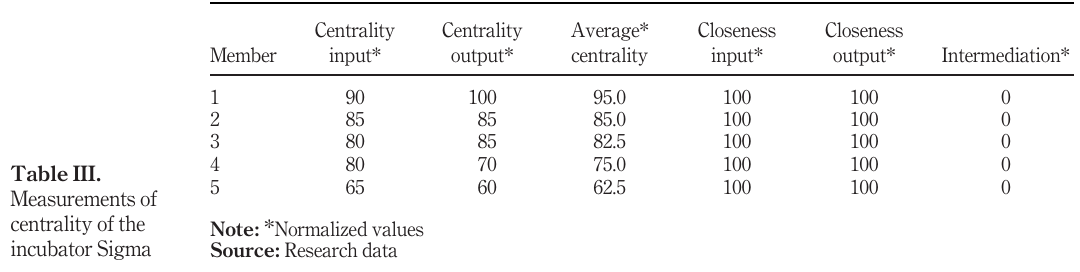
Figure 3. Graph of incubator Sigma